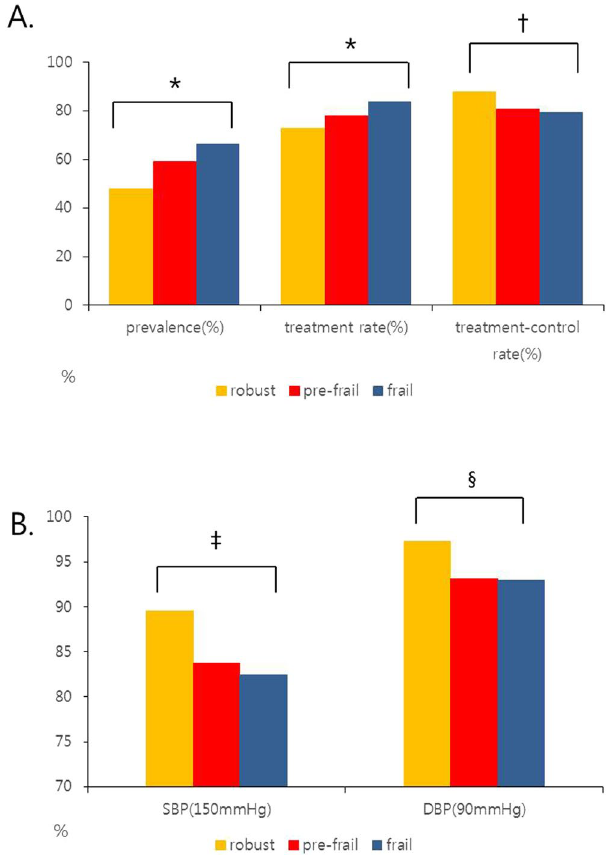
Figure 2. ( A ) Comparison of HTN prevalence and treatment, and control rate according to frailty status. ( * P value < 0.001 , † P value = 0.005 ). HTN prevalence was higher in frail elderly than pre-frail or robust elderly. ( P < 0.001 ) In hypertensive patients, frail elderly are more likely to be treated than pre-frail or robust elderly ( P < 0.001 ). In treated patients, the proportion of patients whose blood pressure was controlled under 150/90 mmHg was significantly lower in frail elderly ( P = 0.005 ). ( B ) Comparison of SBP and DBP control rate in treated patients according to frailty status. ( ‡ P value = 0.020 , § P value = 0.032 ). SBP: systolic blood pressure, DBP: diastolic blood pressure. In treated patients, the proportion of patients whose systolic blood pressure was controlled under 150 mmHg was significantly lower in frail elderly ( P = 0.020 ), and the proportion of patients whose diastolic blood pressure was controlled under 90 mmHg was also lower in frail elderly ( P = 0.032 ).